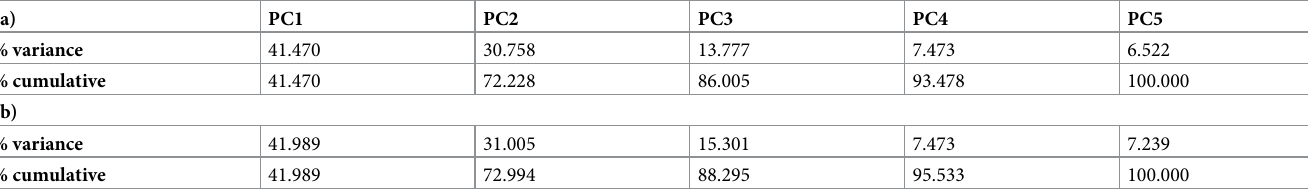
Table 1. Percentage variance of PC1 – PC5 resulting from PCA applied to multispectral images to classify (a) dead trees, and (b) oak and silver birch trees.